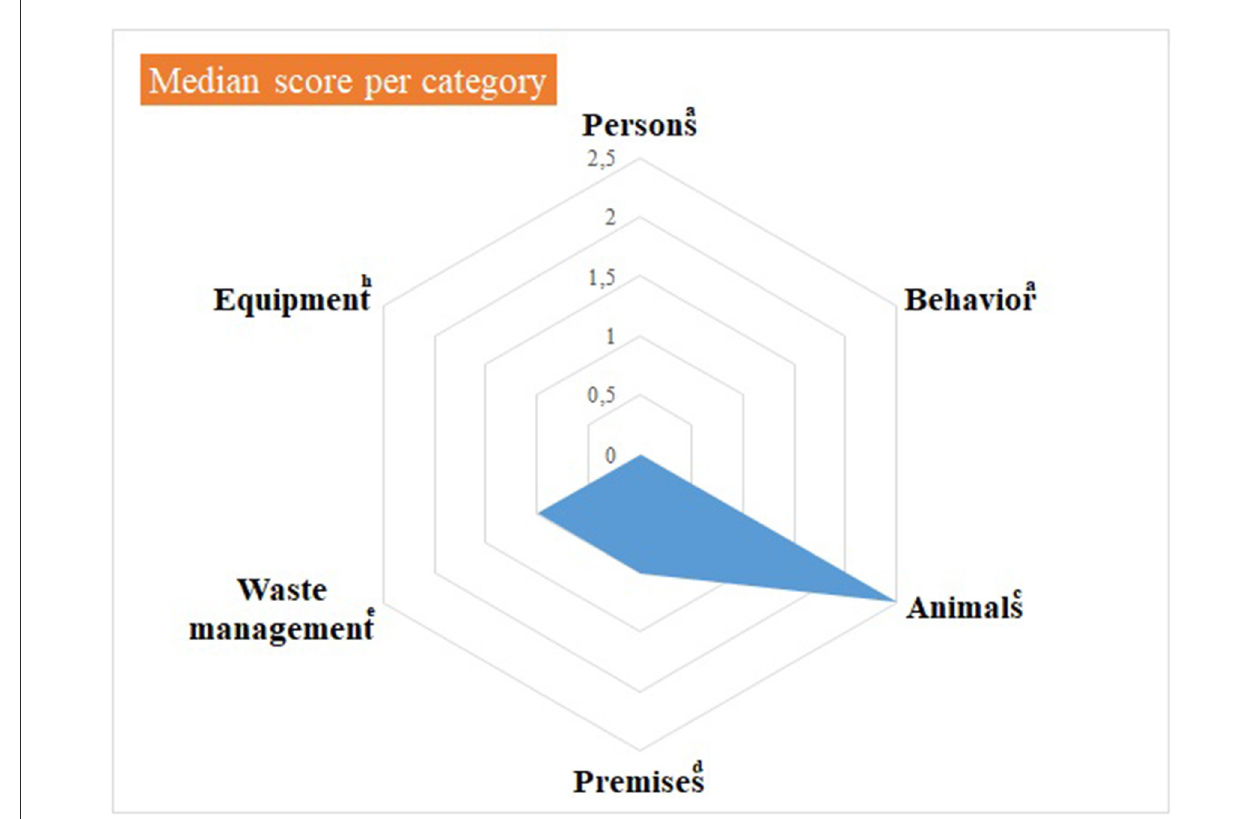
FIGURE2 Illustration of the median score, per category of items, of the internal biosecurity audit performed in the Class 3 of the Equine Clinic. a For the categories “Persons” and “Behavior”, the number of observations ( = the number of people observed per category, i.e. students, scientific staff members and stable staff members) was 7–10 students of 2nd and 3rd master in veterinary medicine (GVM2 and GVM3), 10-12 scientific staff members and 3 stable staff members. c For the category “Animals”, the number of observations was: animals/boxes = 1, consultation = 1, feeding habits = 1 and animal movements = 7. d For the category “Premises”, the number of observations was: boxes = 7, cleaning order = 1, hand hygiene = 5, boot cleaning = 1, foot baths/mats = 5, doors = 1–5, cleaning equipment = 1 and procedure of cleaning and disinfection = 1. e For the “Waste management” category, the number of observations ( = number of waste equipment present in the facilities) was 9. h For the “Equipment” category, there was one observation, i.e. the procedure in force for cleaning and disinfecting. The number of observations per item appears in Supplementary material